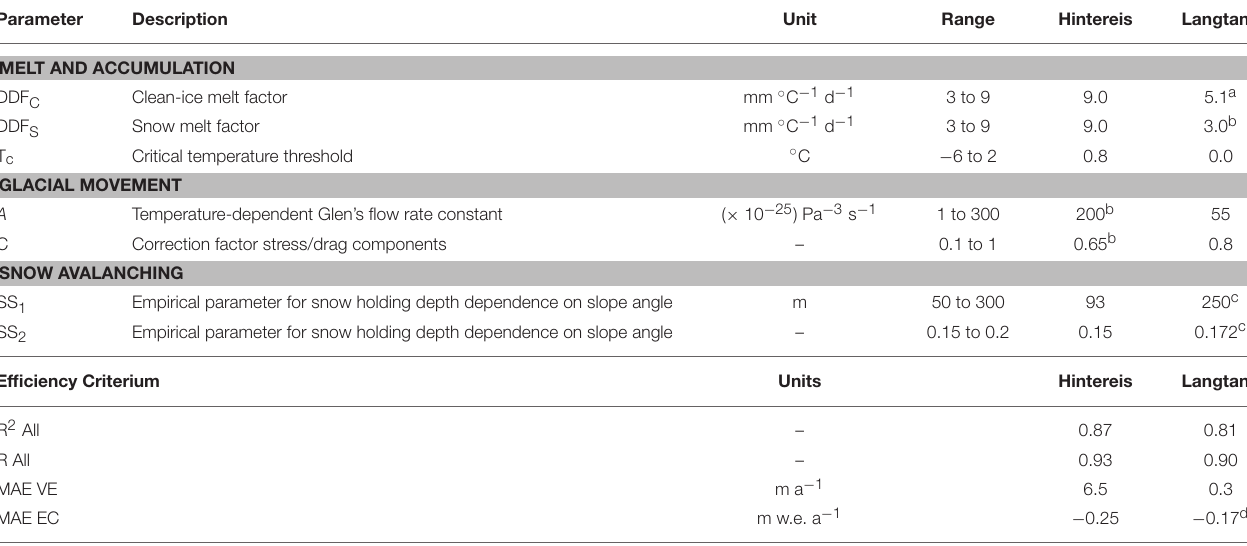
TABLE 2 | Calibrated model parameters, their calibration ranges, and their calibrated values.